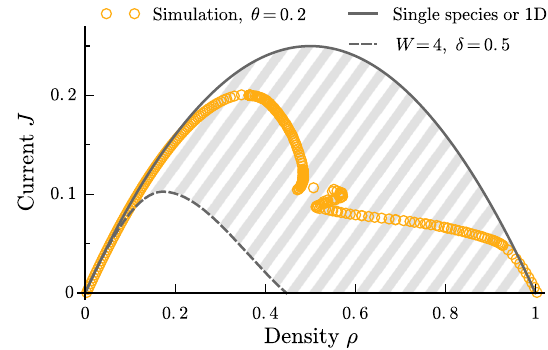
FIG. 9. Current-density relation of a model with nonstrict lane hopping on a system composed of W ¼ 4 lanes. Simulation results (symbols) for the current and density of a model where the lane-switching species switches the lane only with probability θ ¼ 0 . 2 in each step; with probability 1 − θ , the second species follows its current lane. Topological hindrance significantly suppresses current and density for this model also, where lane switching seldomly occurs. The resulting data points are in the area between the current-density relation of the single-species case or one-dimensional model (solid line) and the one of our model (dashed line). For models similar to the one presented in this work but with more realistic particle dynamics (e.g., random particle attachment or detachment, nonstrict lane hopping, dimeric particles), we expect current suppression due to topo- logical hindrance to be stronger for parameters that lead to bigger differences in both curves (shaded area). Thus, our theory provides qualitative insights in more complex models also. Note that the simulations suggest a noninjective current-density relation at the onset of jamming of the original model. Other parameter values are δ ¼ 1 = 2 , L ¼ 16 384